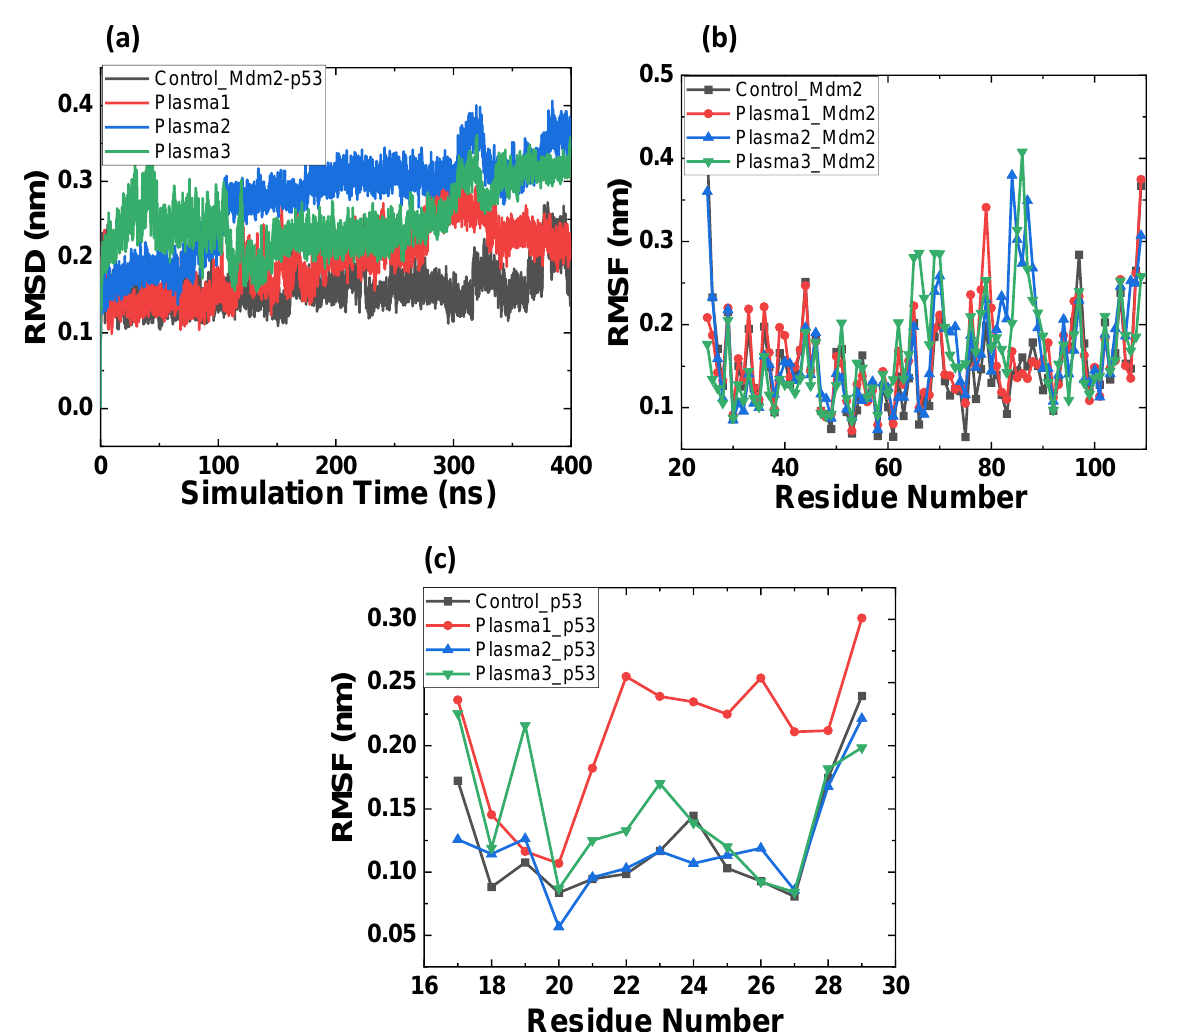
Figure 4. MD simulation results of the native and oxidized Mdm2–p53 protein. ( a ) Root mean square deviation (RMSD) of the C α atoms, ( b ) root mean square fluctuations of Mdm2 control or oxidized in the different complex, and ( c ) root mean square fluctuations of p53 control or oxidized in the different complex.